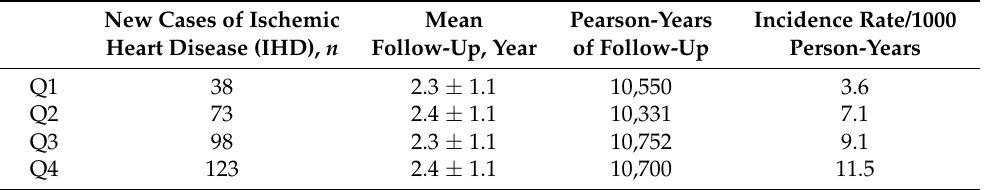
Table 2. Overall incidence of ischemic heart disease according to the atherogenic index of plasma (AIP) quartiles. New Cases of Ischemic